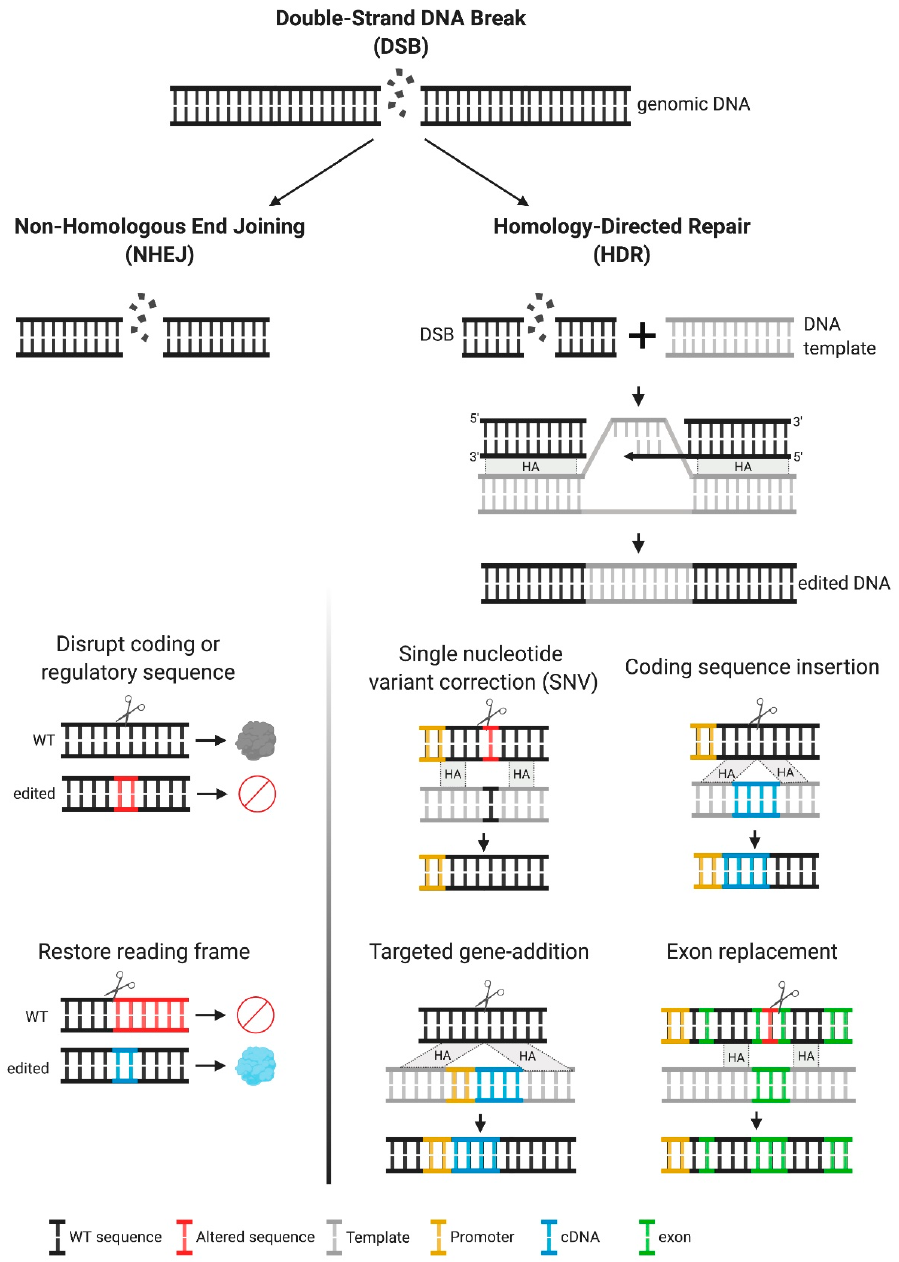
Figure 2. Multiple genetic modifications and their therapeutic applications. Upon a double-strand break (DSB), DNA can be repaired by two mechanisms, non-homologous end joining (NHEJ) or homology directed repair (HDR). The first mechanism frequently results in insertions or deletions (indels). Inducing indels can be used for disruption of coding sequences or to restore the reading frame, for frameshift mutations. For HDR to occur, a DNA template containing the desired modification, with homology arms flanking the target site is required. This approach is recommended when specific DNA modifications are intended, as this is an error-free repair mechanism. HDR can result in the following modifications, depending on the template used—single nucleotide variant (SNV), insertion of coding sequences under their own endogenous promoter control or alternative endogenous promoters, addition of genes (promoter + cDNA) in safe harbor loci, and replacement of partial coding sequences (one or multiple exons).